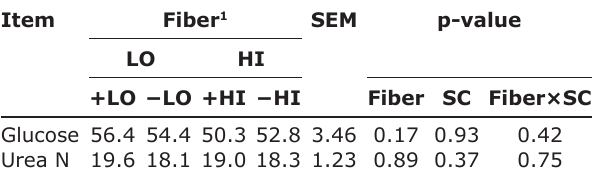
LO=Low, HI=High, SC= Saccharomyces cerevisiae , SEM=Standard error of the mean Table-5: Effect of SC supplementation in Awassi female lambs fed with LO- and HI-fiber diets on serum concentrations (mg/dL) of glucose and urea